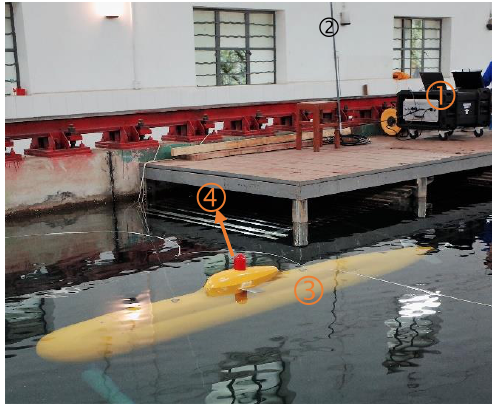
Figure 1. The xAUV sailing in the towing tank. ( 1 ) Portable surface monitor; ( 2 ) Surface WIFI antenna; ( 3 ) xAUV; ( 4 ) Integrated WIFI&GPS antenna.